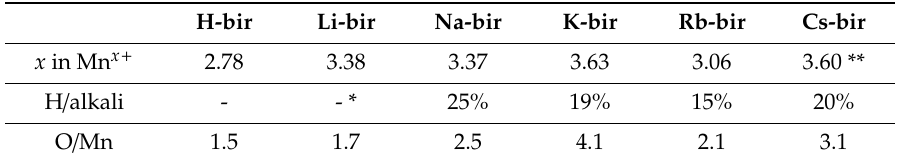
Table 2. The average oxidation state of Mn determined by the Mn 3s range analysis, atomic fraction of alkali of the surface (excluding carbon), and atomic ratio of surface oxygen (O 1s) and Mn (Mn 2p) from the quantitative analysis. H-bir